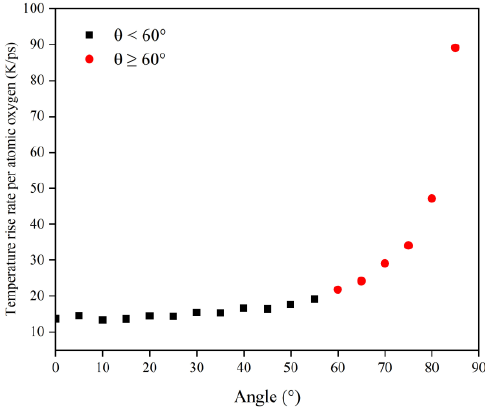
Figure 19. Temperature rise of the Kapton caused by per atomic oxygen at different incident angles at different time nodes.